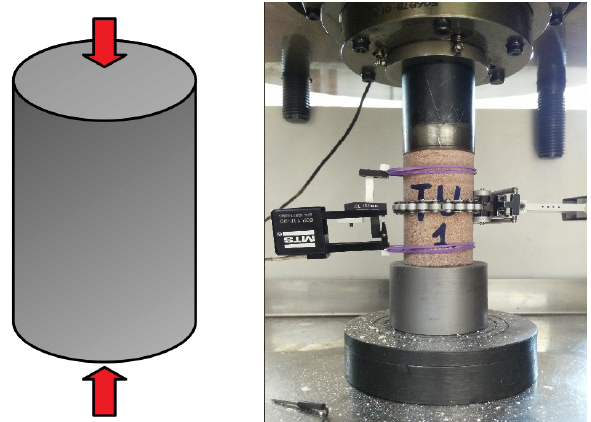
Fig. 5: Schematic representation of the uniaxial compression test. Sample is compressed from the top and bottom until failure. On the left – simplified scheme of the test, on the right – laboratory experiment.